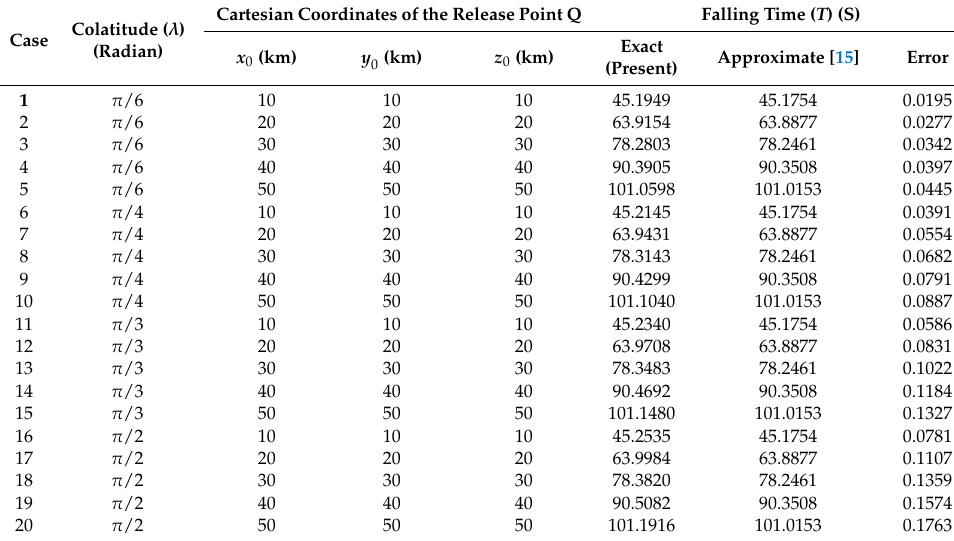
Table 1. Comparisons between the present values of the falling time ( T ) (s) and the corresponding results in [15] at various values of the colatitude ( λ ) (radian) and the release point Q. Colatitude ( λ ) Case